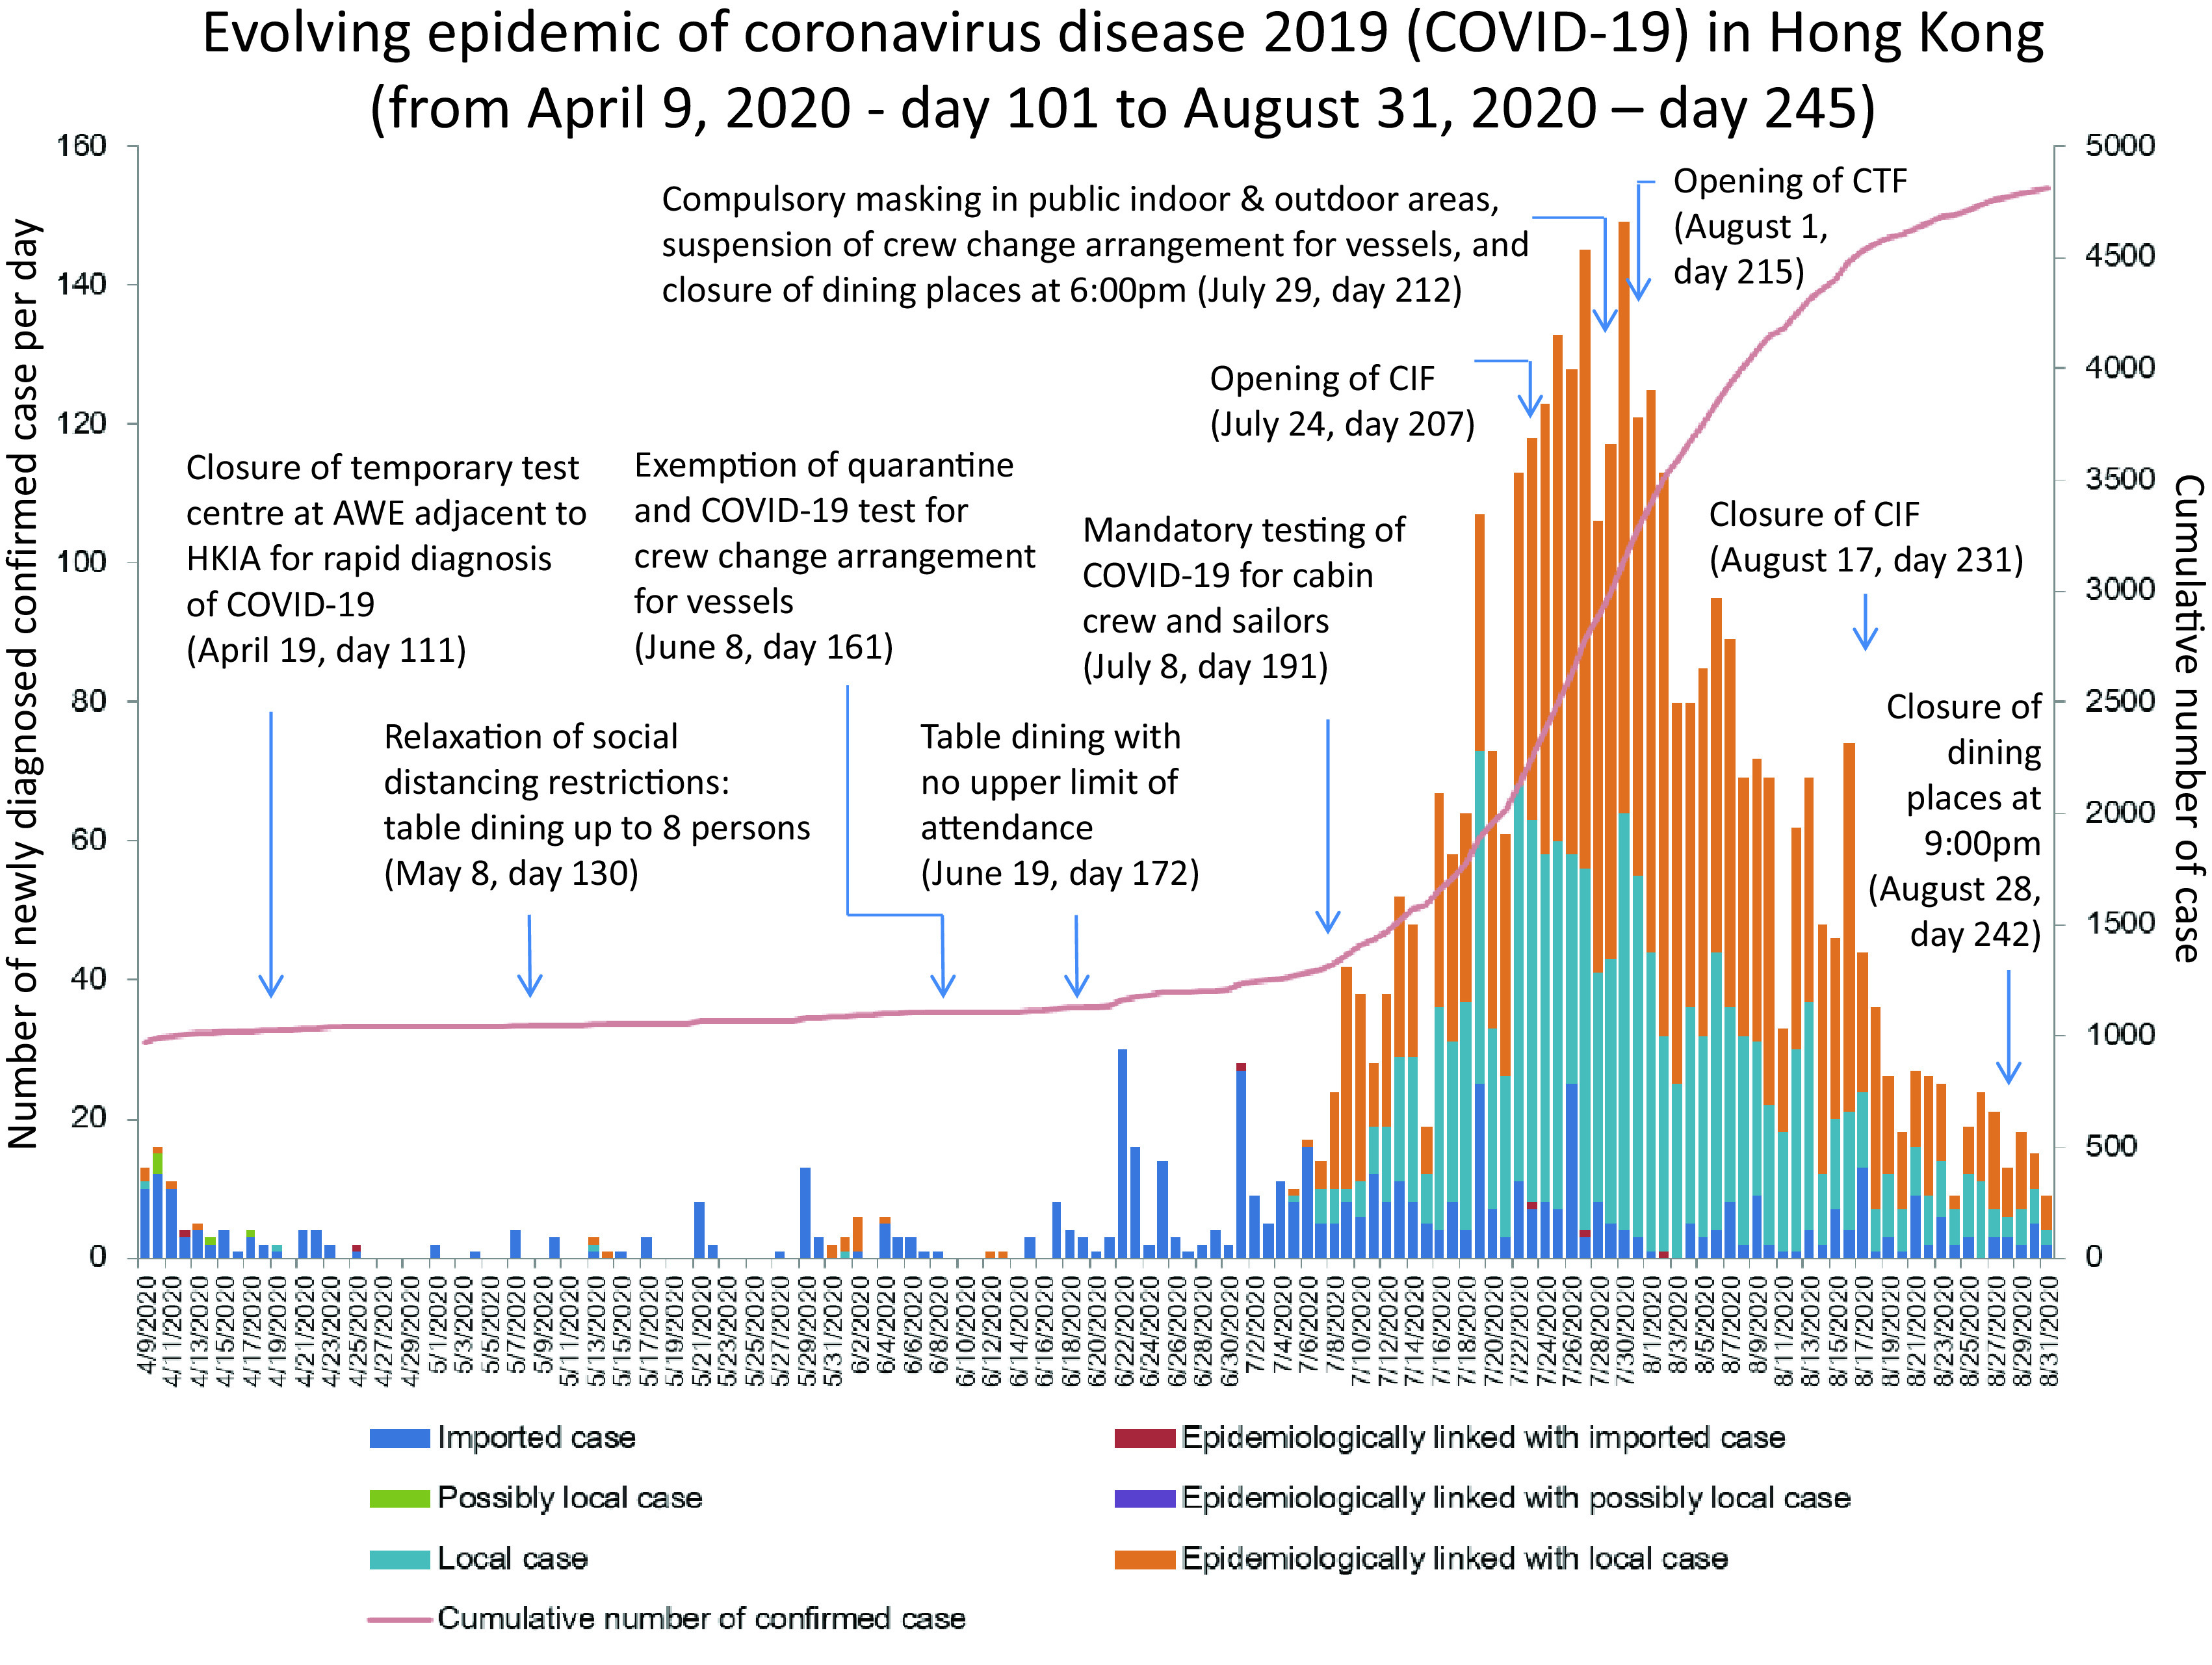
Evolving epidemic of COVID-19 in Hong Kong from April 9, 2020 (day 101) to August 31, 2020 (day 245). Official announcement of the community acquired pneumonia outbreak in Wuhan, Hubei Province by National Health Commission of the People’s Republic of China, on December 31, 2019 is defined as day 1. Note. AWE, AsiaWorld-Expo; HKIA, Hong Kong International Airport; CIF, community isolation facility at Lei Yue Mun Park and Holiday Village; CTF, community treatment facility at AsiaWorld-Expo adjacent to the Hong Kong International Airport.